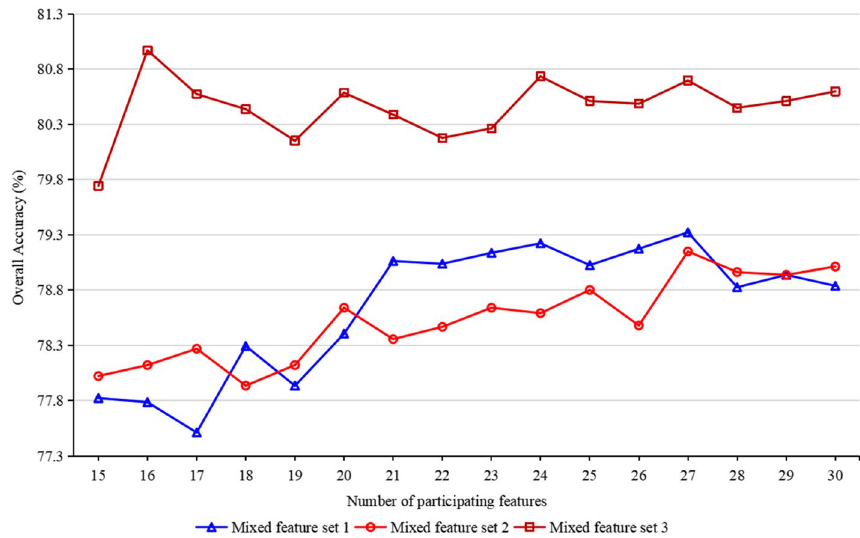
Fig. 6 Relationship between the number of participating important features and the overall accuracy of tree species identification, based on WorldView-2. According to the importance values of different features in Table 8 in Appendix, the classification results of all the top 15–30 features were selected for